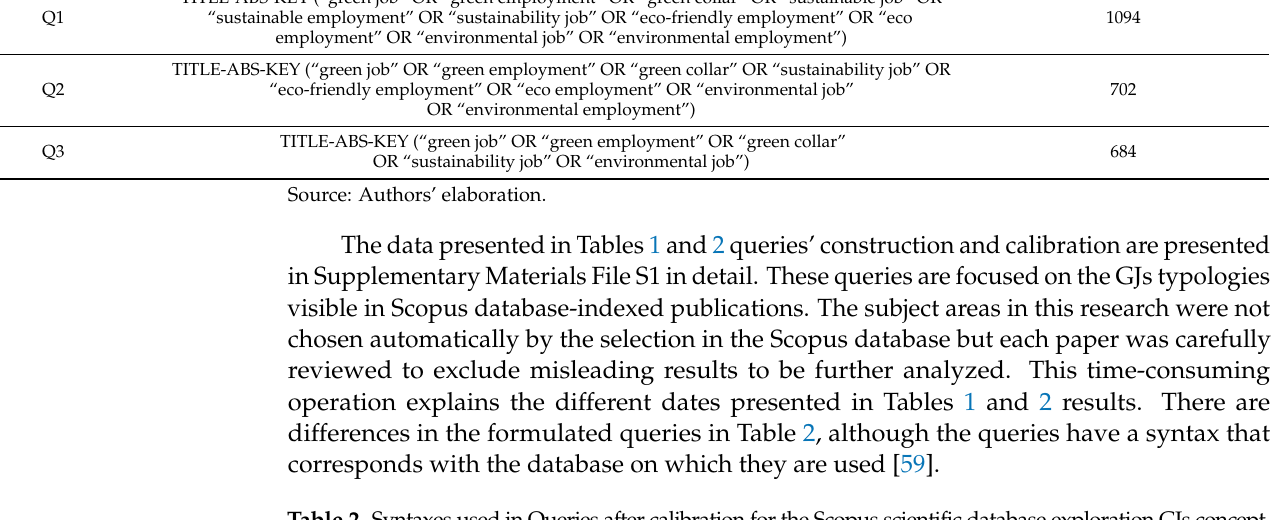
Table 2. Syntaxes used in Queries after calibration for the Scopus scientific database exploration GJs concept. No. Query Syntax No. of Results (31 December